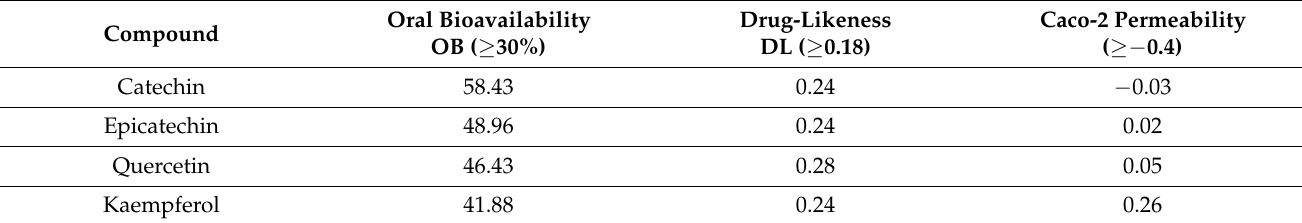
Table 1. The ADME properties of the bioactive compounds of Moringa oleifera found in Traditional Chinese Medicine Systems Pharmacology (TCMSP).